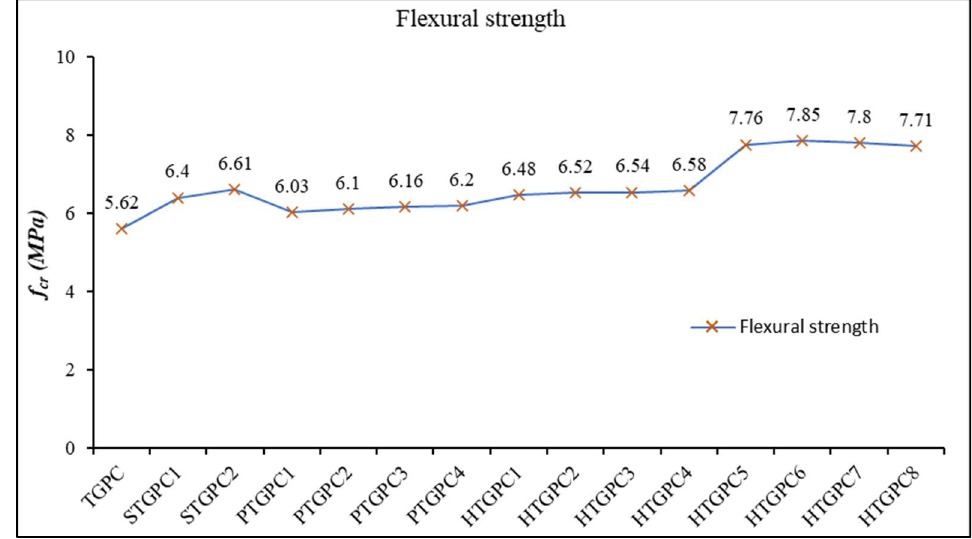
Figure 7. Comparison of modulus of rupture.